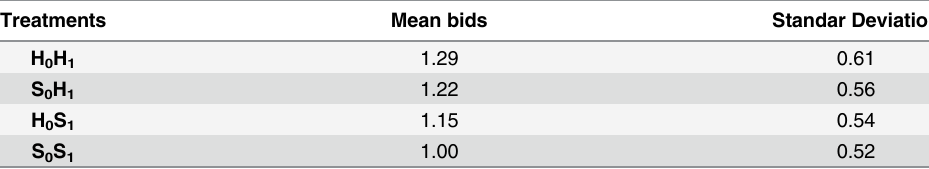
Table 6. Average Bids across the four treatments( € /100 grams). Treatments Mean